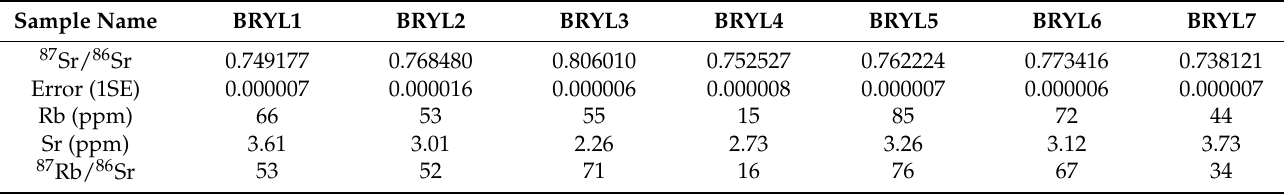
Table 3. Rb-Sr abundances and Sr isotope ratios of the beryl